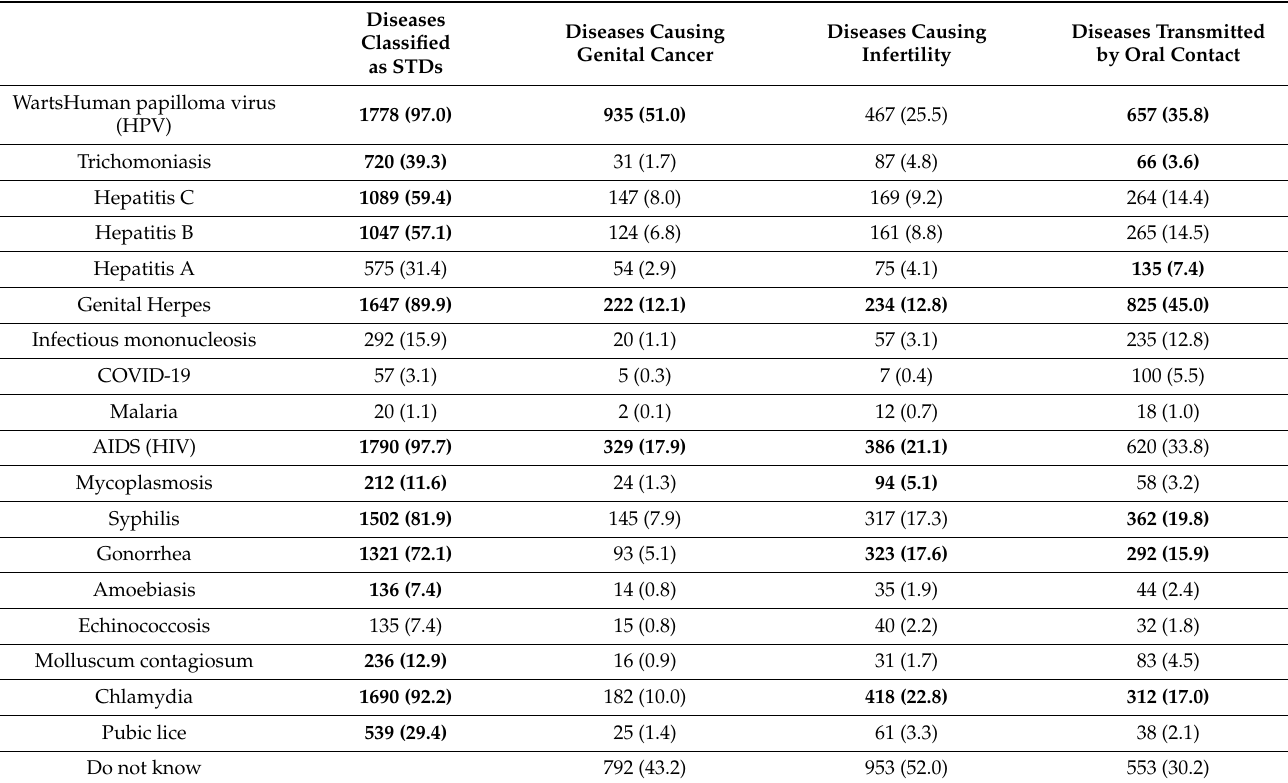
Table 2. Knowledge of the young population regarding STDs and prevention methods.